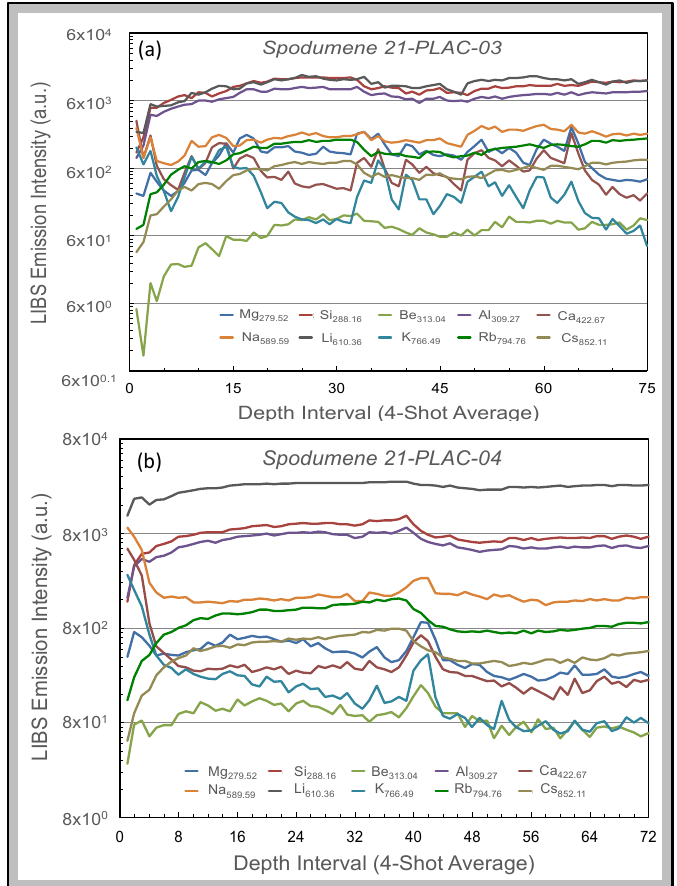
Figure 10. Depth profiles illustrating compositional variations just below the surface in two spodumene crystals from outcrops 21-PLAC-03 and 21-PLAC-04 on the Carolina Lithium Project prospect in Gaston County, N.C. Emission intensities are displayed for 10 elements (Mg, Si, Be, Al, Ca, Na, Li, K, Rb, and Cs) for 300 successive laser shots at a single spot on spodumene 21-PLAC-03 grouped into 4-shot averages ( a ) and 288 successive laser shots at a single spot on spodumene 21-PLAC-04 also grouped into 4-shot averages ( b ).